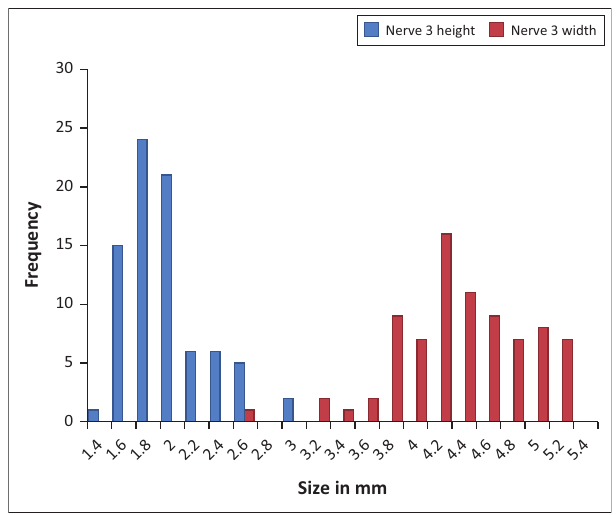
FIGURE 6: Frequency distribution of the intracranial optic nerve.